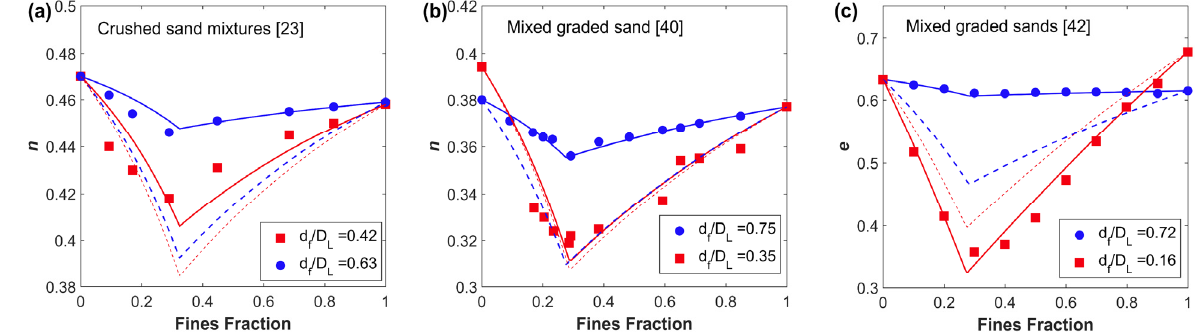
Figure 3. Porosity ( n ) or void ratio ( e ) as function of fines fraction for different binary mixed soils. Subfigures ( a )–( c ) show different examples from different binary mixed soils where data sources are displayed in the upper left corner for each plot. The fine-to-large grain size ratio d f / D L for each mixture is shown where blue data points represent mixtures characterized by larger d f / D L compared to red data points. The dashed blue and red curves correspond to the prediction from the original model (Equations (1)–(3)) while the current modified model (Equations (1), (2) and (6)) predictions are shown in solid curves.